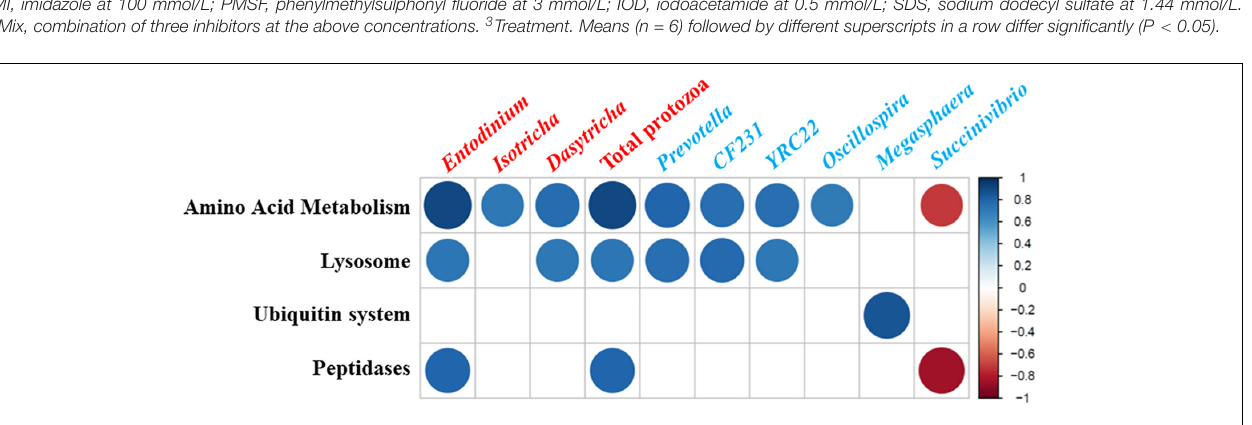
Fibrobacter and other known fibrolytic bacteria such as species of Ruminococcus